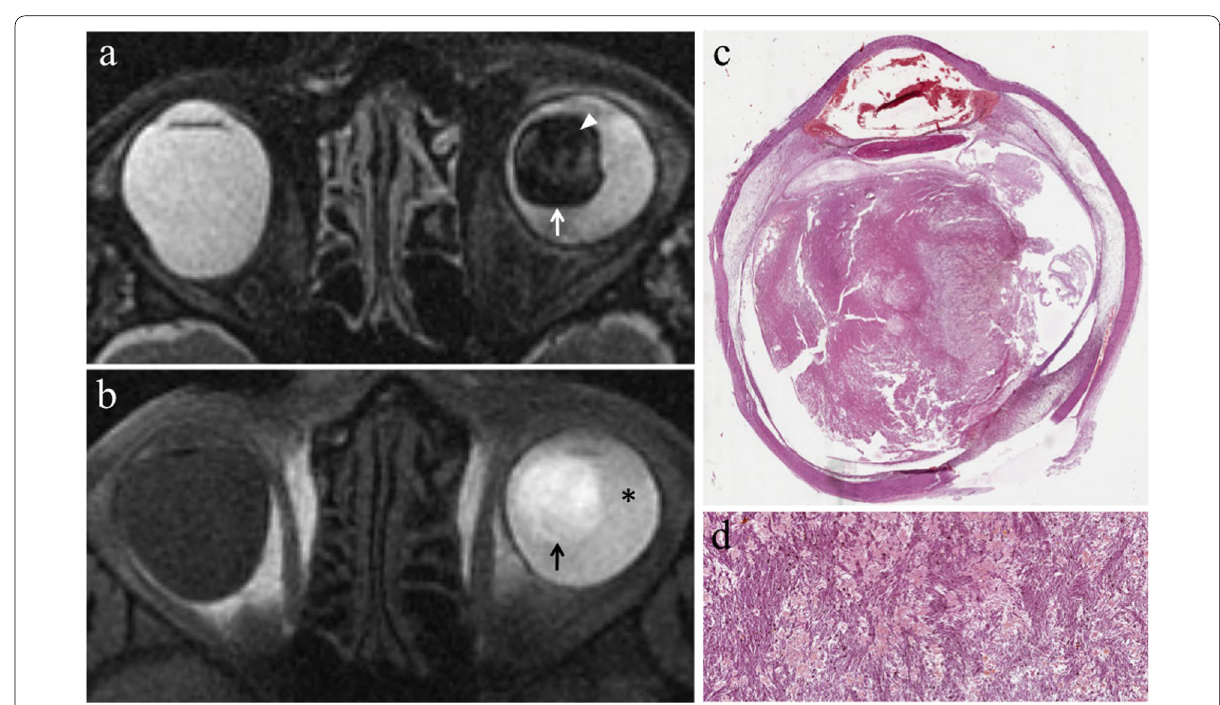
Fig. 7 An 82-year-old man with a choroidal melanoma of the left eye treated with plaque brachytherapy. The patient underwent secondary enucleation seven years after radiotherapy because of painful eye and local recurrence. Axial a T2-weighted turbo spin-echo STIR and b fat-suppressed T1-weighted images. Along the medial aspect of the left globe an intraocular mass (arrows) exhibits inhomogeneous signal intensity with irregularly edged hypointense areas on T2-weighted image (white arrowhead in a ), due to radiation-induced fibrotic alterations. The anterior chamber and the vitreous body of the left eye demonstrate high signal intensity on T1-weighted image (black asterisk in b ), a finding consistent with extensive vitreous hemorrhage. Note the difference with the physiological water-like signal intensity of the contralateral eye. c Histological low magnification showing the heterogeneous appearance of the tumor, composed of poorly pigmented spindle cells, intermingled with dense and eosinophilic intratumoral fibrotic areas (H&E, original magnification 25 ). d On higher magnification, the fibrotic nature of the above-described × eosinophilic areas is well documented: neoplastic spindle cells are mixed to multiple deposits of dense collagen fibres, representing the main effect of radiotherapy (H&E, original magnification 100 ×